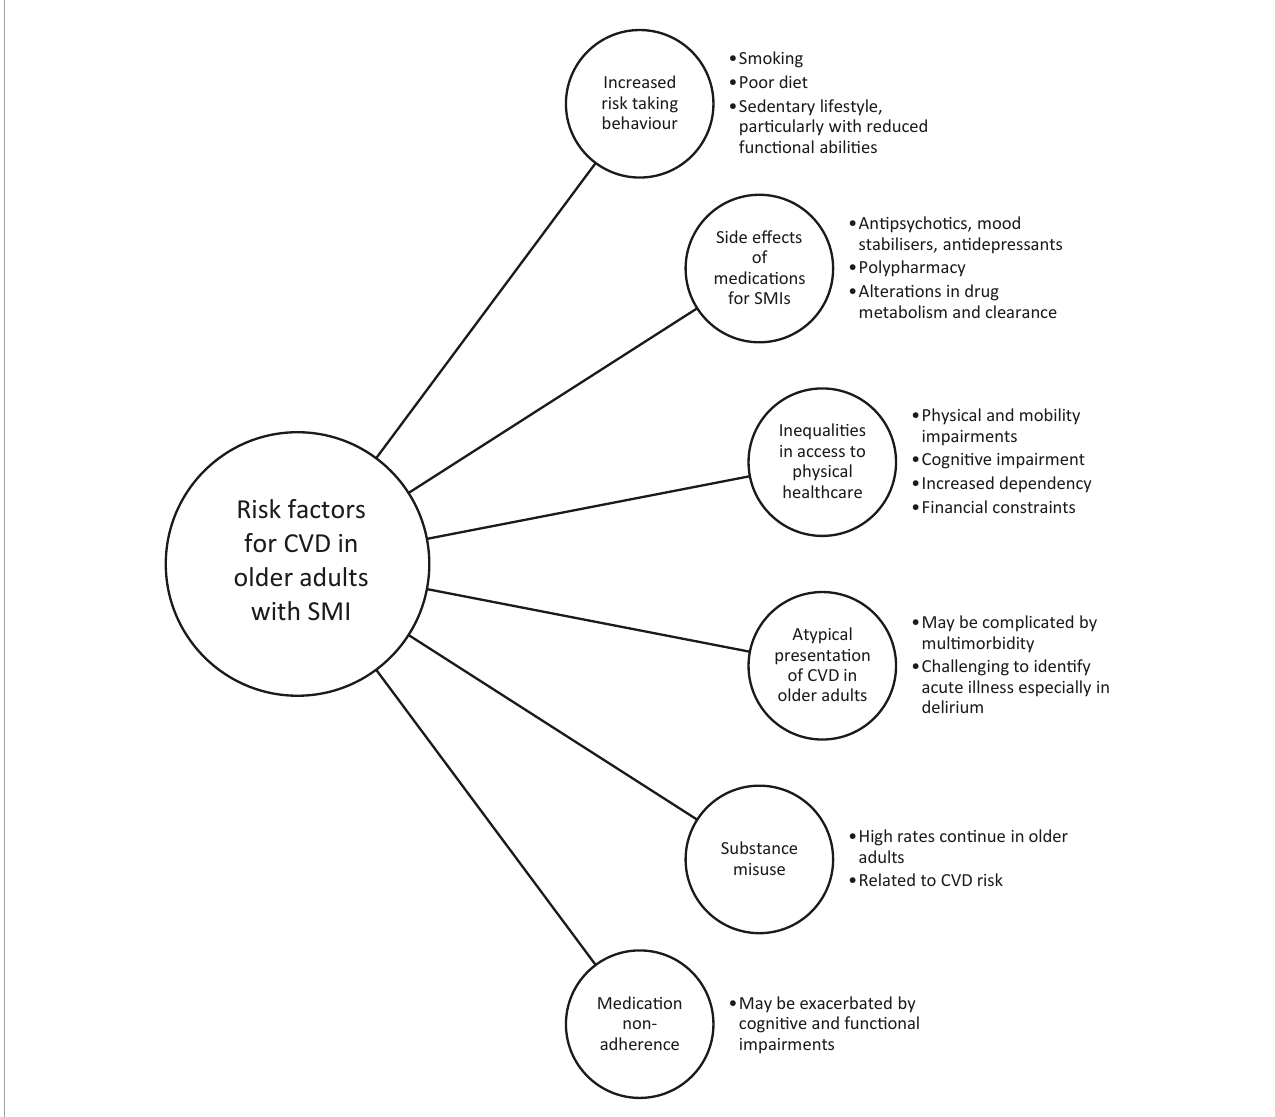
FIGURE1 Summary of risk factors for cardiovascular disease (CVD) in older people living with serious mental illness